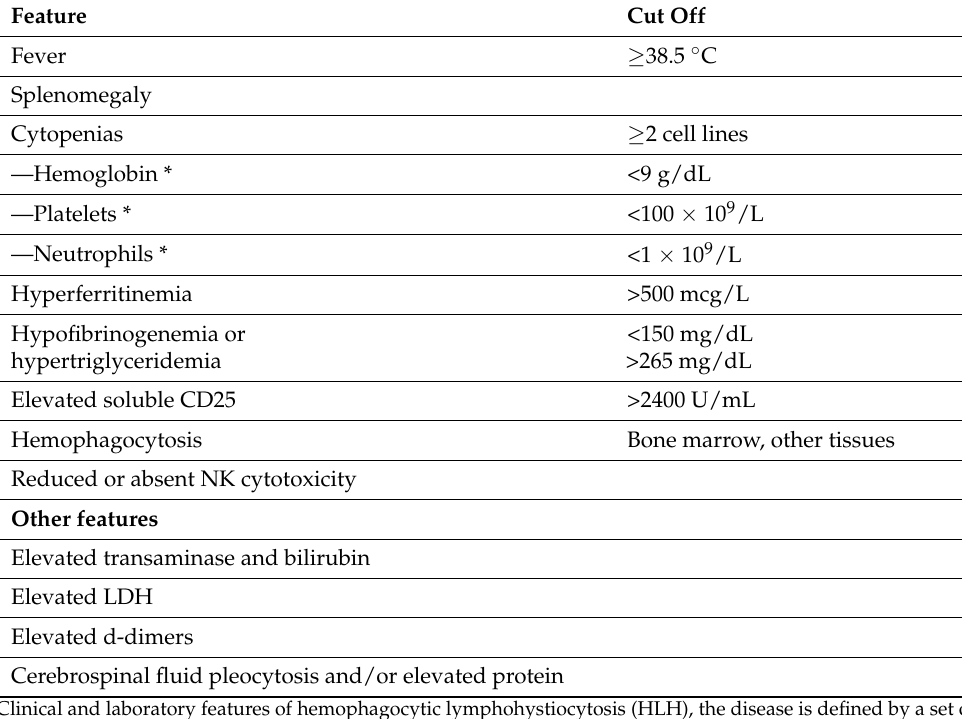
Table 1. Hemophagocytic lymphohistocytosis (HLH)-2004 diagnostic